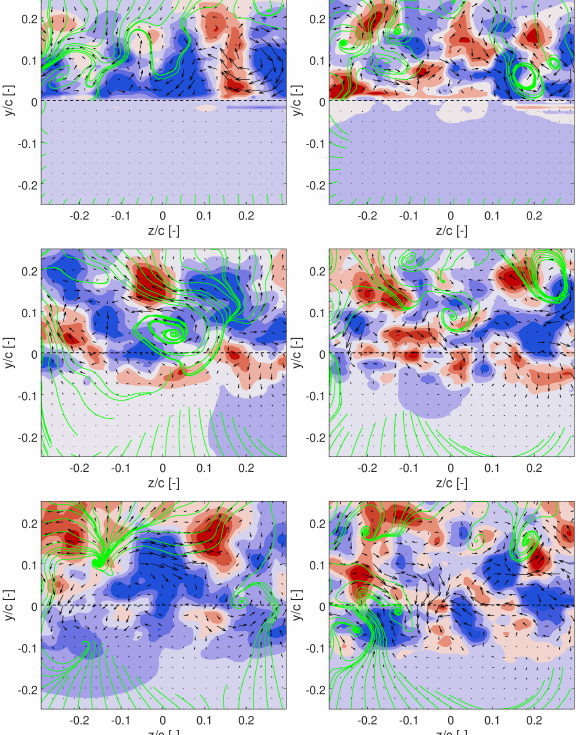
Fig. 12 . Parts of streamwise normal planes x/c = 1, 1.3, 1.5 (top to bottom). POD modes of velocity no. 1 (left) & 4 (right). Content ~4.6% & ~3.2% of TKE.